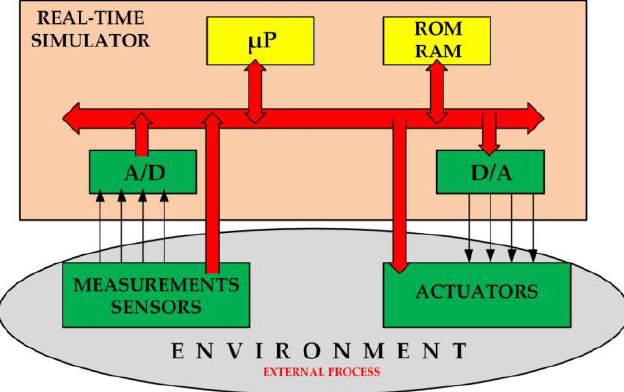
Figure 1. Schematic diagram of the real-time simulator.